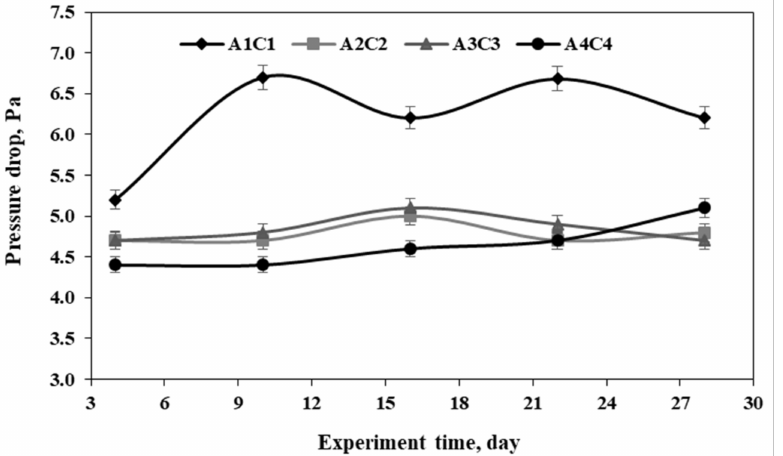
Figure 5. The pressure drop (Pa) across the biofilter packing material (between the points A1 and C1, A2 and C2, A3 and C3, and A4 and C4) composed of WPP, NWCM, and WF. The airflow rate also has an influence on the pressure drop across the packing